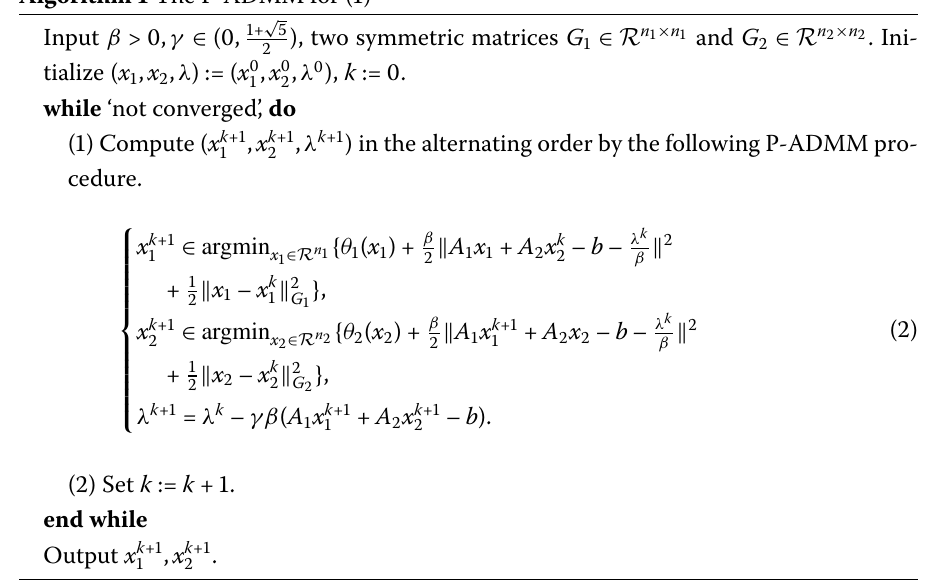
Algorithm  The P-ADMM for